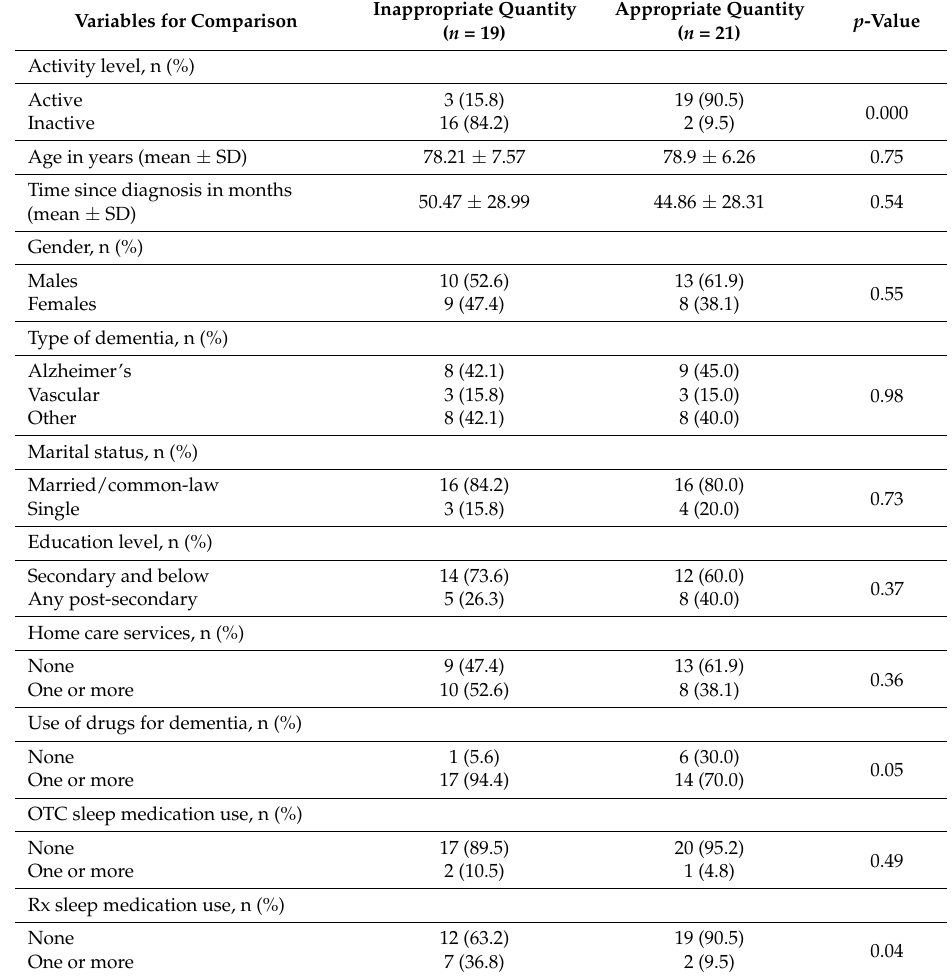
Table 3. Characteristics of PWD by sleep